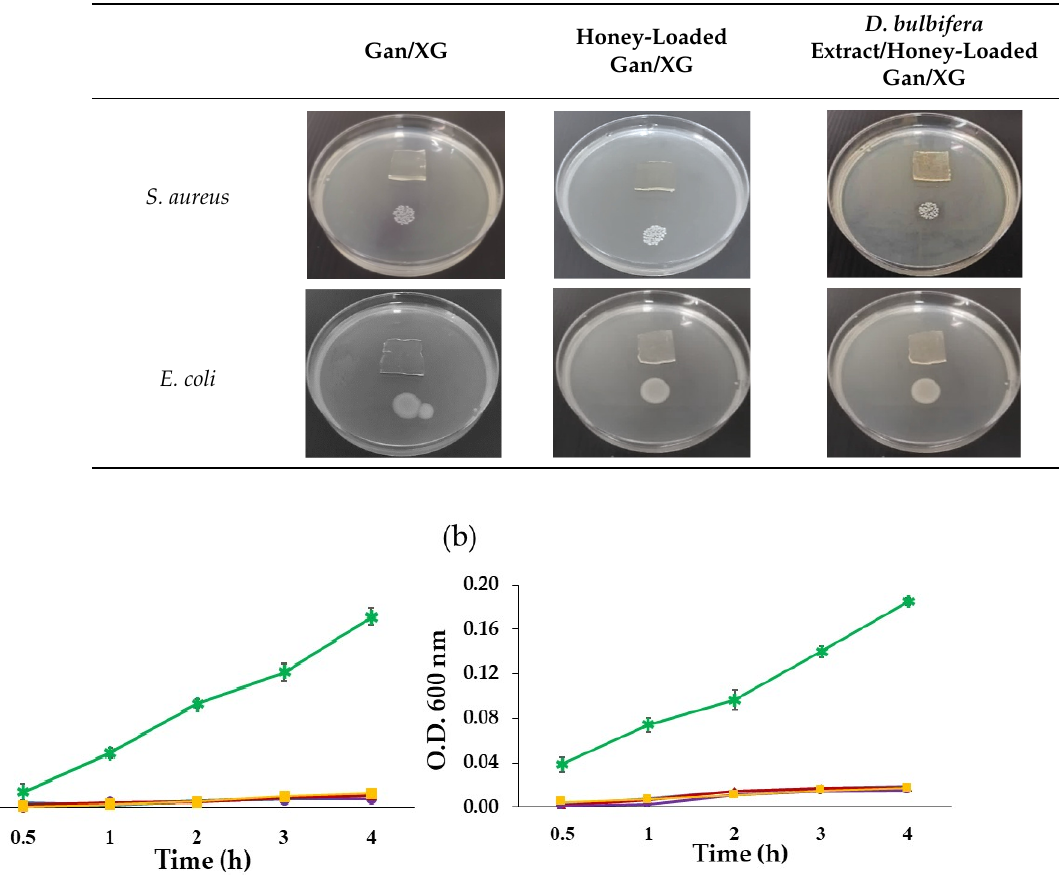
Figure 5. Infiltration bacterial test: ( a ) S. aureus and ( b ) E. coli of hydrogel patches: ( ) agar without bacteria, ( ) agar with bacteria, ( ) Gan/XG hydrogel patch, ( ) honey-loaded Gan/XG hydrogel patch, and ( ) D. bulbifera extract/honey-loaded Gan/XG hydrogel patch.